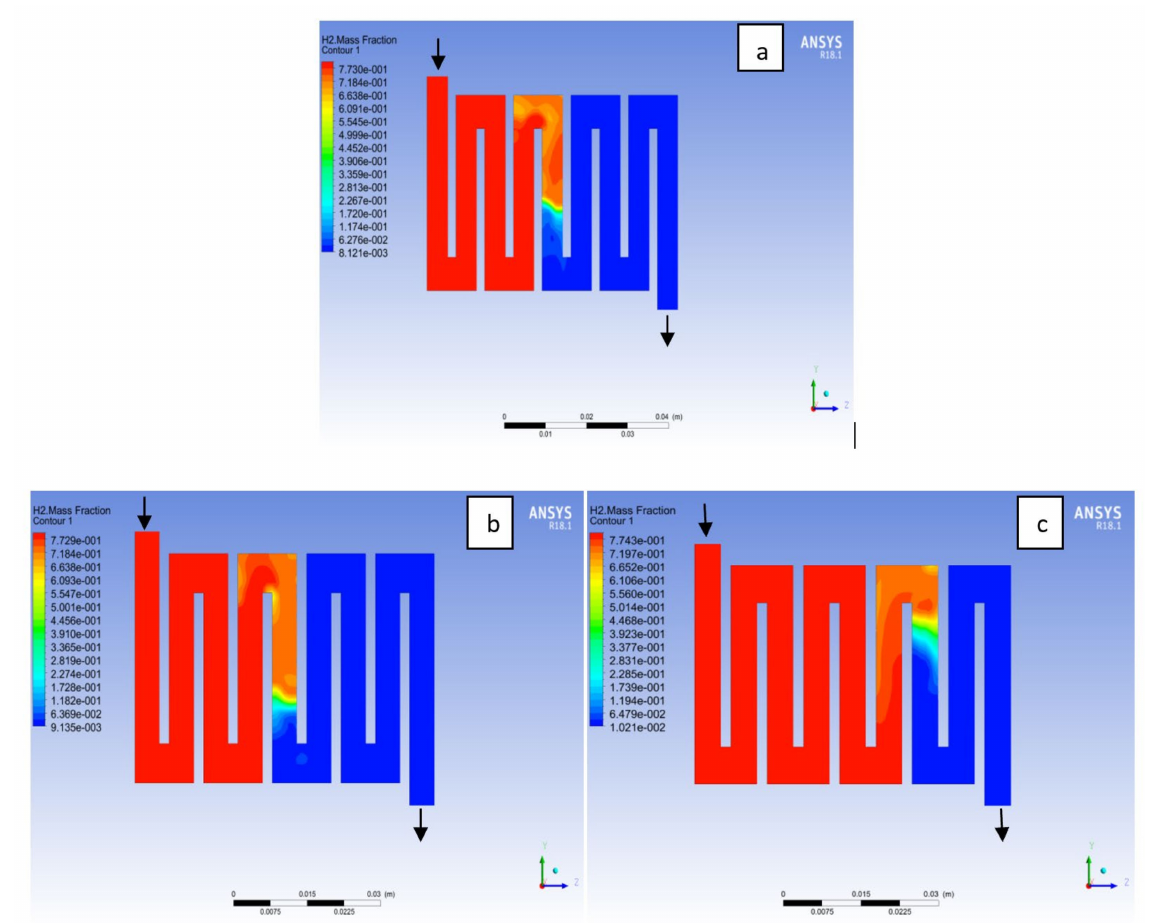
Figure 16. Contours of hydrogen mass fraction at the anode region (GDL/CL) for each material with temperature 323 K at pressure 1.5 bar: ( a ) Aluminum, ( b ) Copper, ( c )